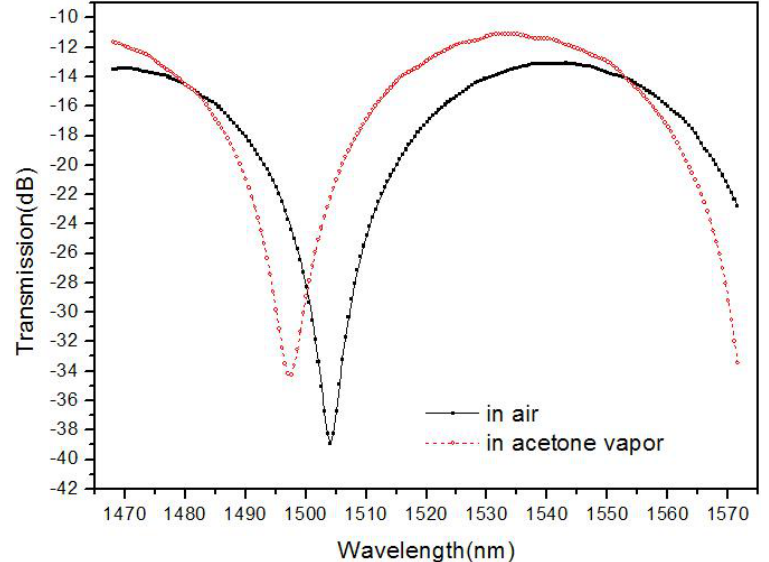
Figure 5. Sensing test results in air and acetone vapor at room